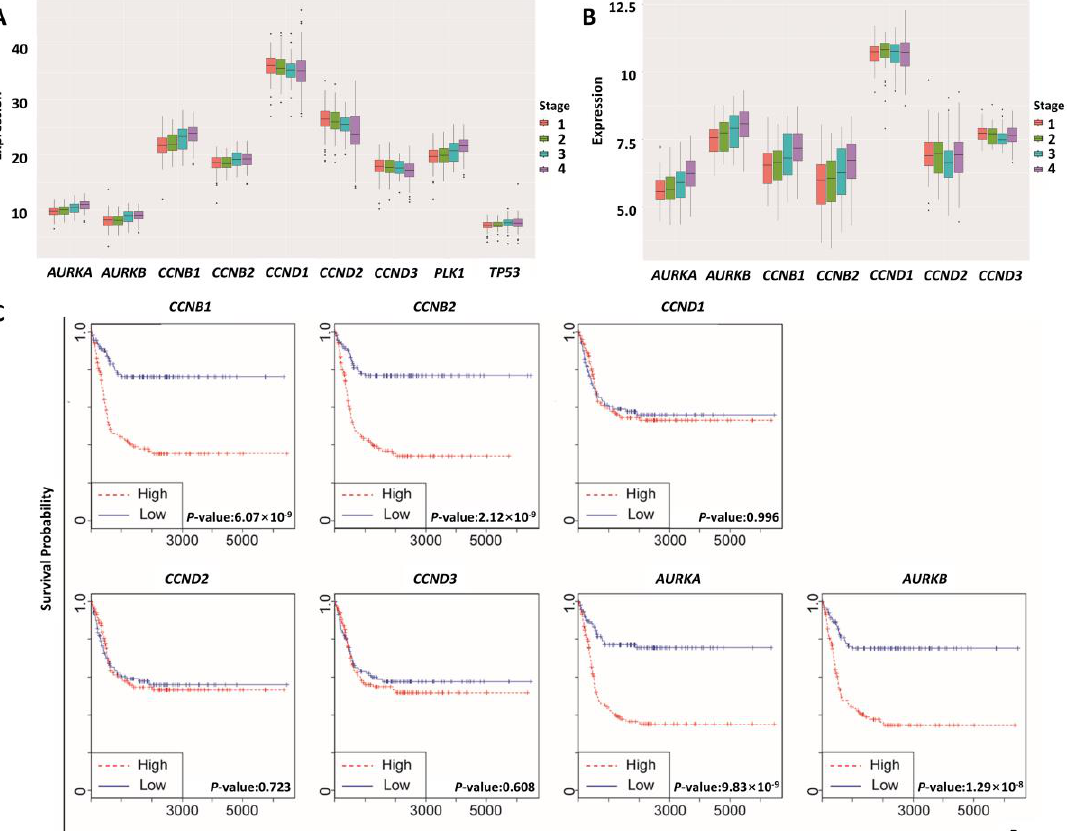
Figure 3. Expression patterns of mitosis-regulatory genes in neuroblastoma patients. ( A ) Gene- expression patterns of CCNB1 , CCNB2 , CCND1 , CCND2 , CCND3 , AURKA , AURKB , PLK1 , and TP53 in GSE49710. ANOVA tests for all stages in the genes were performed ( p -values: CCNB1 , 2 × 10 −16 ; CCNB2 , 4.57 × 10 −5 ; CCND1 , 0.081; CCND2 , 3.83 × 10 −9 ; CCND3 , 0.000346; AURKA , 2 × 10 −16 ; AURKB , 1.71 × 10 −13 ; PLK1 , 2 × 10 −16 ; TP53 , 0.000786). The y -axis indicates messenger RNA (mRNA) expression. ( B ). Gene-expression patterns of CCNB1 , CCNB2 , AURKA , and AURKB in GSE85047, according to stages ( p -values of ANOVA tests: CCNB1 , 3.95 × 10 −7 ; CCNB2 , 7.15 × 10 −6 ; CCND1 , 0.898; CCND2 , 0.42; CCND3 , 0.336; AURKA , 8.63 × 10 −7 ; AURKB , 4.62 × 10 −5 . The y -axis indicates mRNA expression. ( C ) Progression-free survival plots and log-rank test p -values of CCNB1 , CCNB2 , CCND1 , CCND2 ,